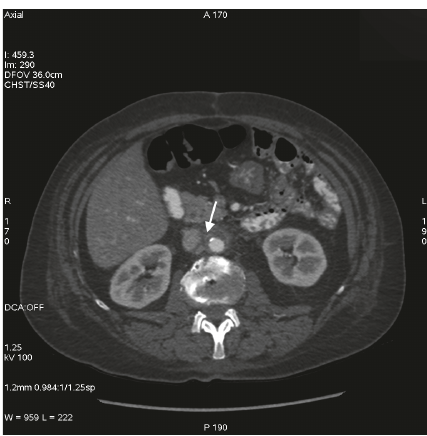
Figure 1: Abdominal CT scan (day 1) revealing infrarenal periaortic infiltrates in contact with the inferior vena cava (arrow) .